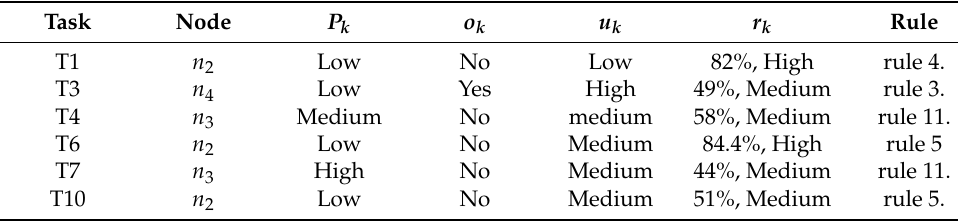
Table 5. S 2 decision making based on three